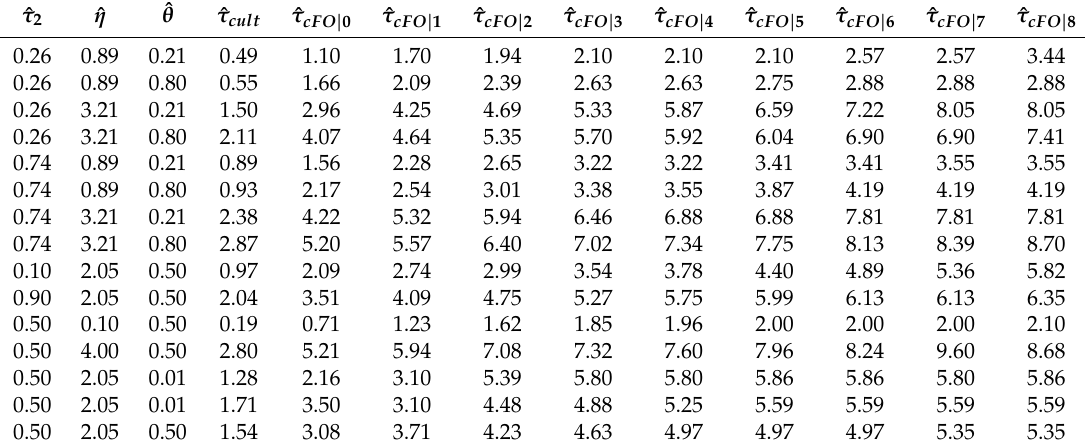
Table A1. Experimental design results.